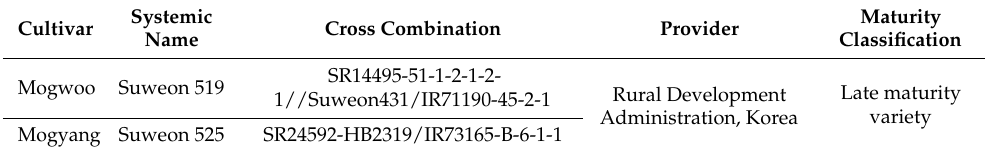
Table 1. The cross combination and main characteristics of ‘Mogwoo’ and ‘Mogyang’ in forage rice. Cultivar